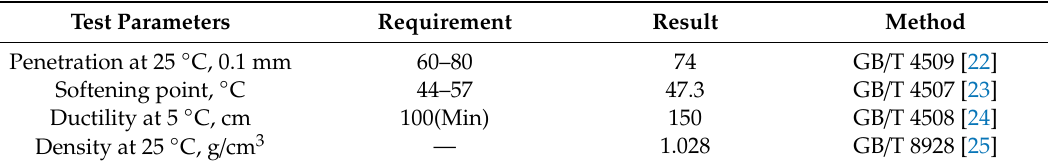
Table 2. Basic performance of the base asphalt binder.